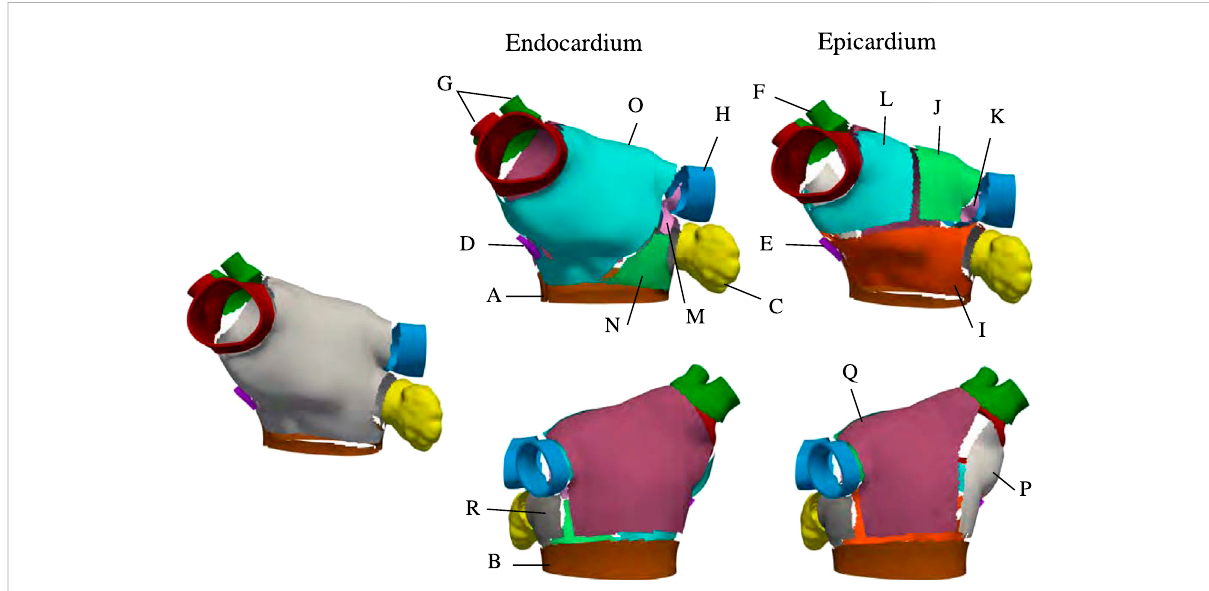
FIGURE 3 Region selection in M75. The left panel shows the regions common to the endocardial and epicardial layers that are fi rst extracted by the algorithmAfterthosearede fi ned,theendocardialanteriorissplitintothreeregionsandtheepicardialanteriorwallissplitintofourregions.Then,the lateral and posterior walls are de fi ned in both layers. Notice that, in the epicardium, the inferior part of the septum is de fi ned as separate